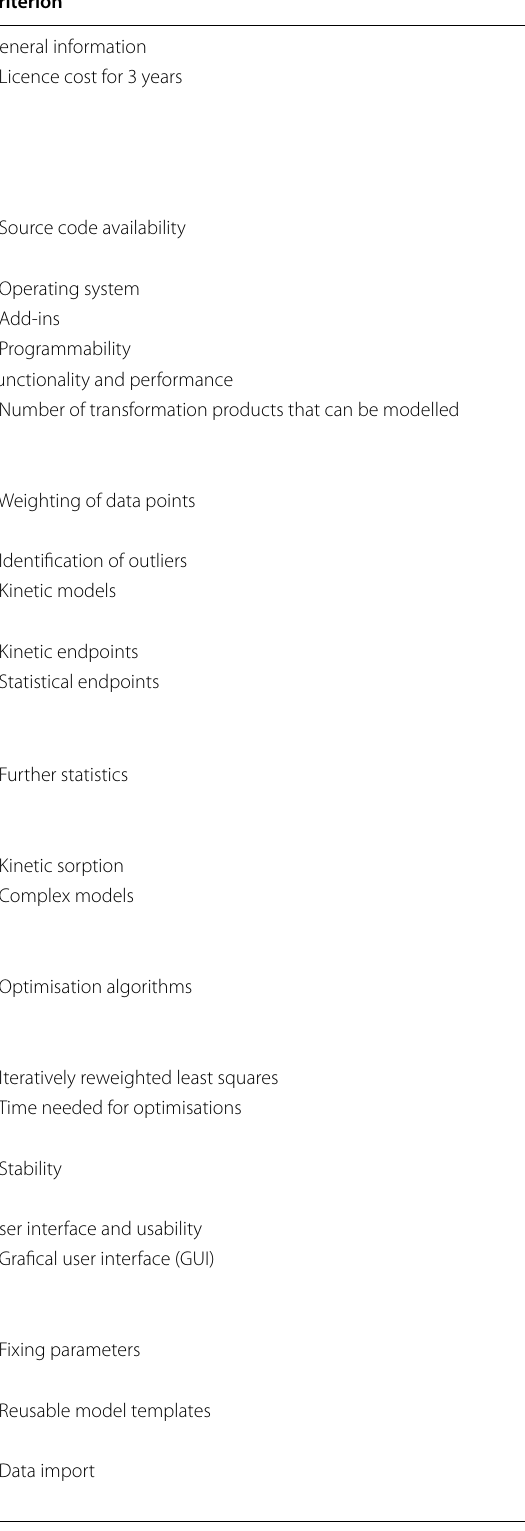
Table 2 Criteria, attributes and their scores used for the quantitative comparison